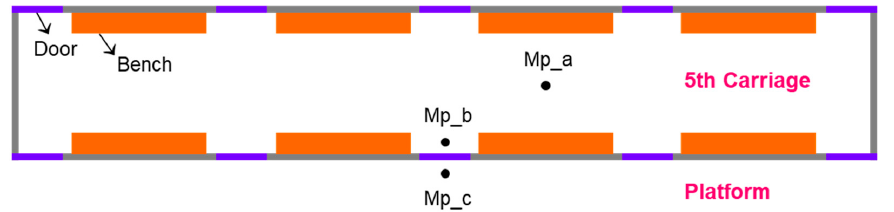
Figure 3. Measurement points in all campaigns. Mp_a represents the measurement points when exploring the influences of driving routes and passenger number on PM concentrations in the carriage. Mp_b and Mp_c represent the measurement points in the carriage and on the platform when exploring the influence of the door opening and closing on in-carriage PM concentrations,